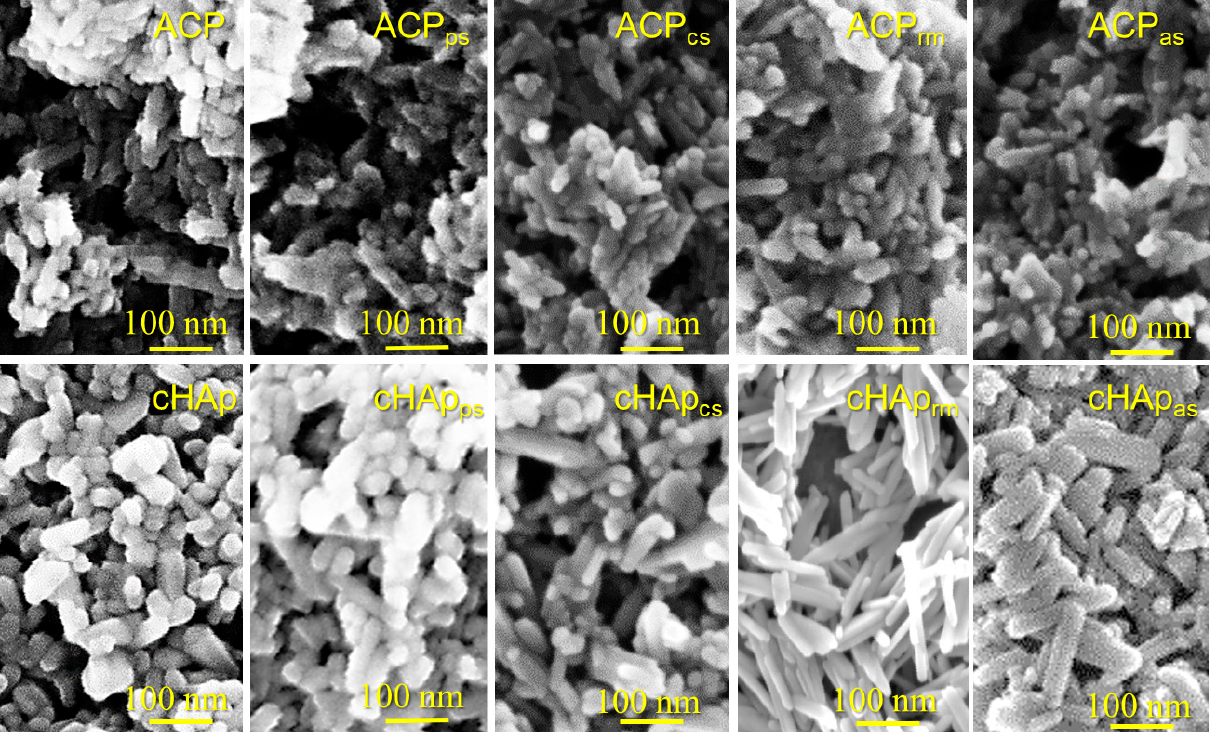
Figure 2. SEM micrographs of unloaded and STR-loaded ACP and cHAp nanoparticles.